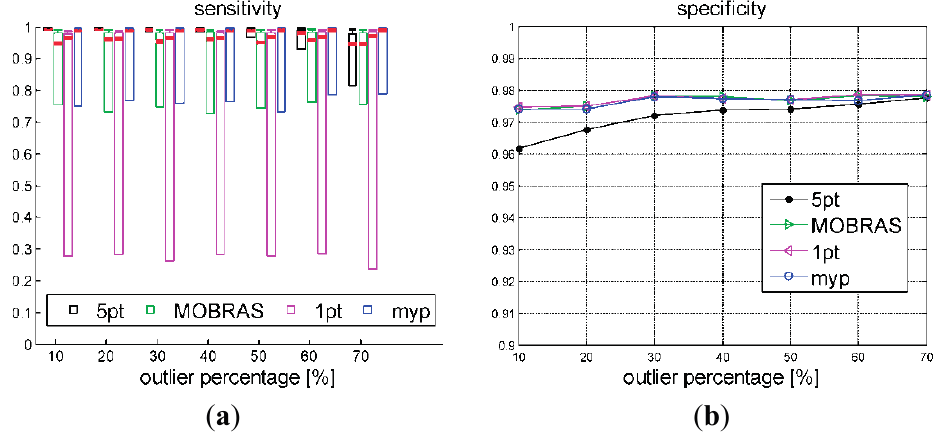
Figure 8. Sensitivity and specificity of true inliers detection vs. outlier percentage. Vehicle velocity is fixed at 50 km/h.